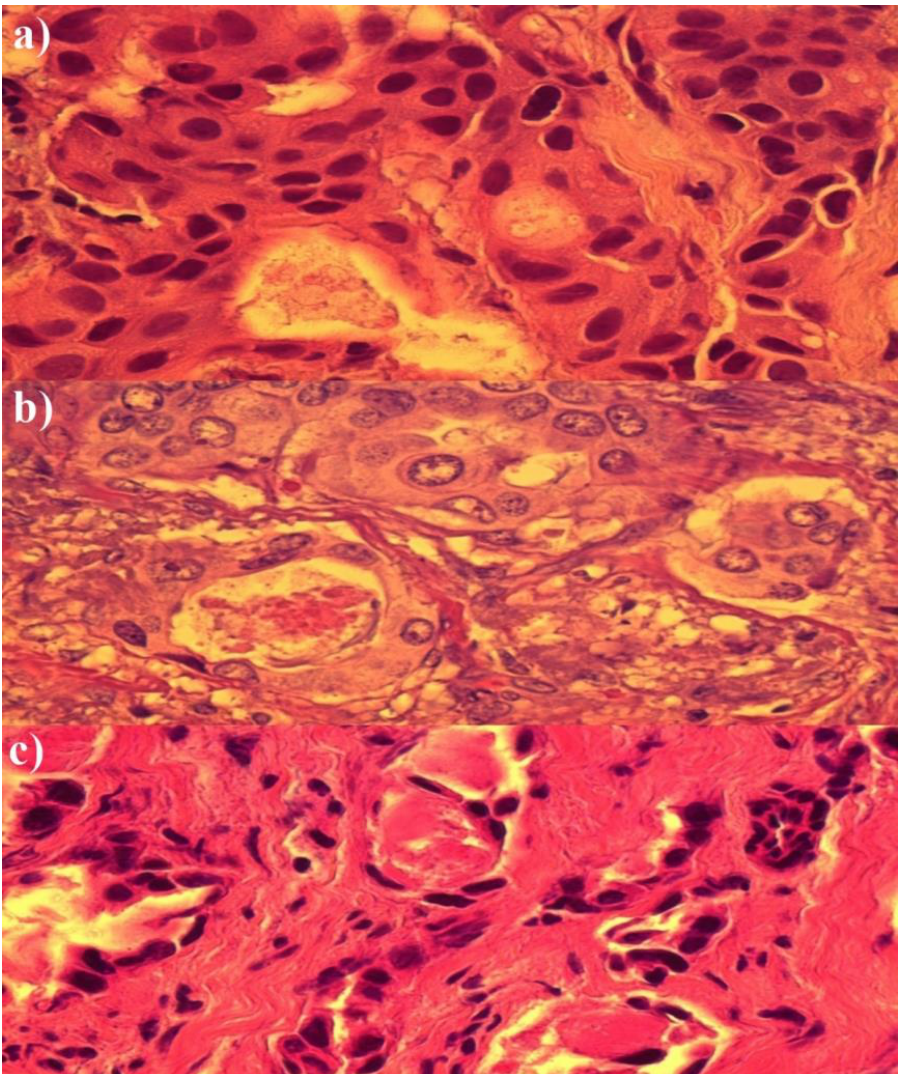
Figure 2. The representative image of histopathological material of cancer tissue ( a ) before chemotherapy, ( b ) after chemotherapy, and ( c ) after chemotherapy and photodynamic action (Rose Bengal 0.03 g/mL).